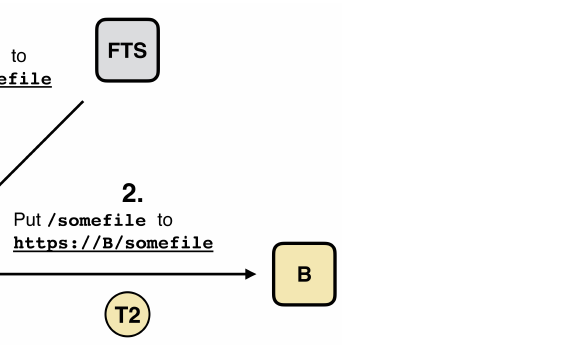
Figure 2. The third-party transfer phase as triggered by FTS against SE A